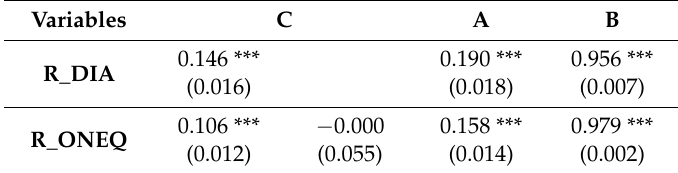
Table 19. Diagonal BEKK for US Market ETF returns (Before GFC) (3 October 2003 to 30 October 2007).